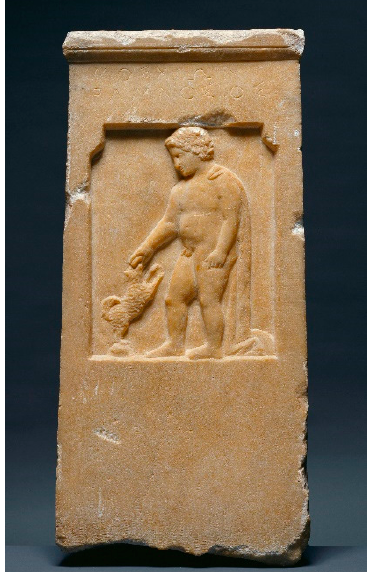
Figure 19. Moschion stela. The J. Paul Getty Museum, Villa Collection, Malibu, California, 73.AA.117. Digital image courtesy of the Getty’s Open Content Program.